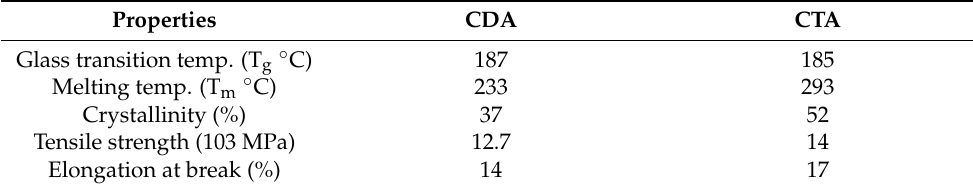
Figure 1. Molecular structures of ( A ) cellulose, ( B ) cellulose diacetate (CDA), and ( C ) cellulose triacetate (CTA). Table 1. Comparison of dense film properties of CDA and